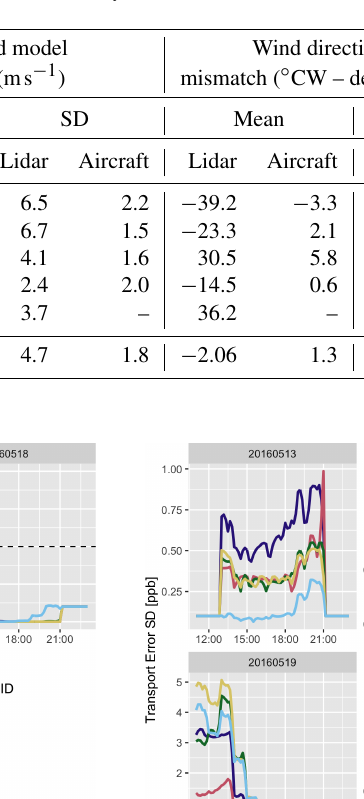
Table 3. Mean and standard deviations of wind speed and wind direction differences between the NAM model winds and observations from the ALAR aircraft and the wind lidar. Negative values indicate that the NAM model value is greater than the observation. The ALAR–NAM standard deviations for each day were used in the transport error analysis.